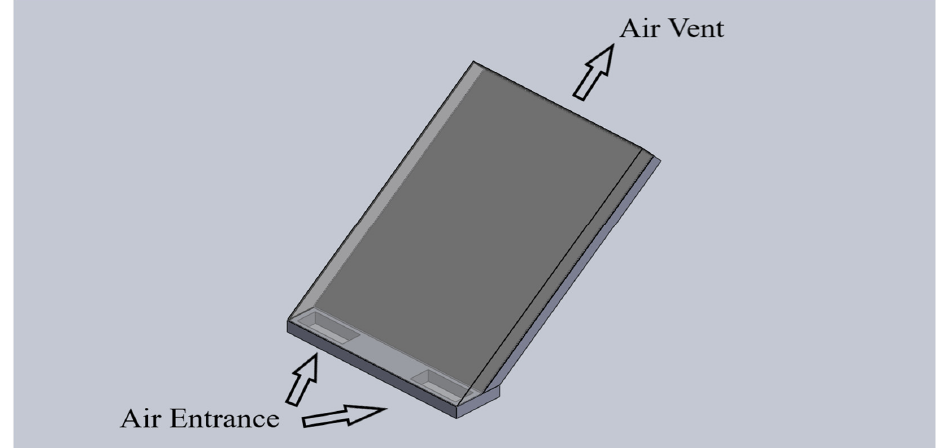
Figure 5. Solar chimney SolidWorks model and its boundary conditions.